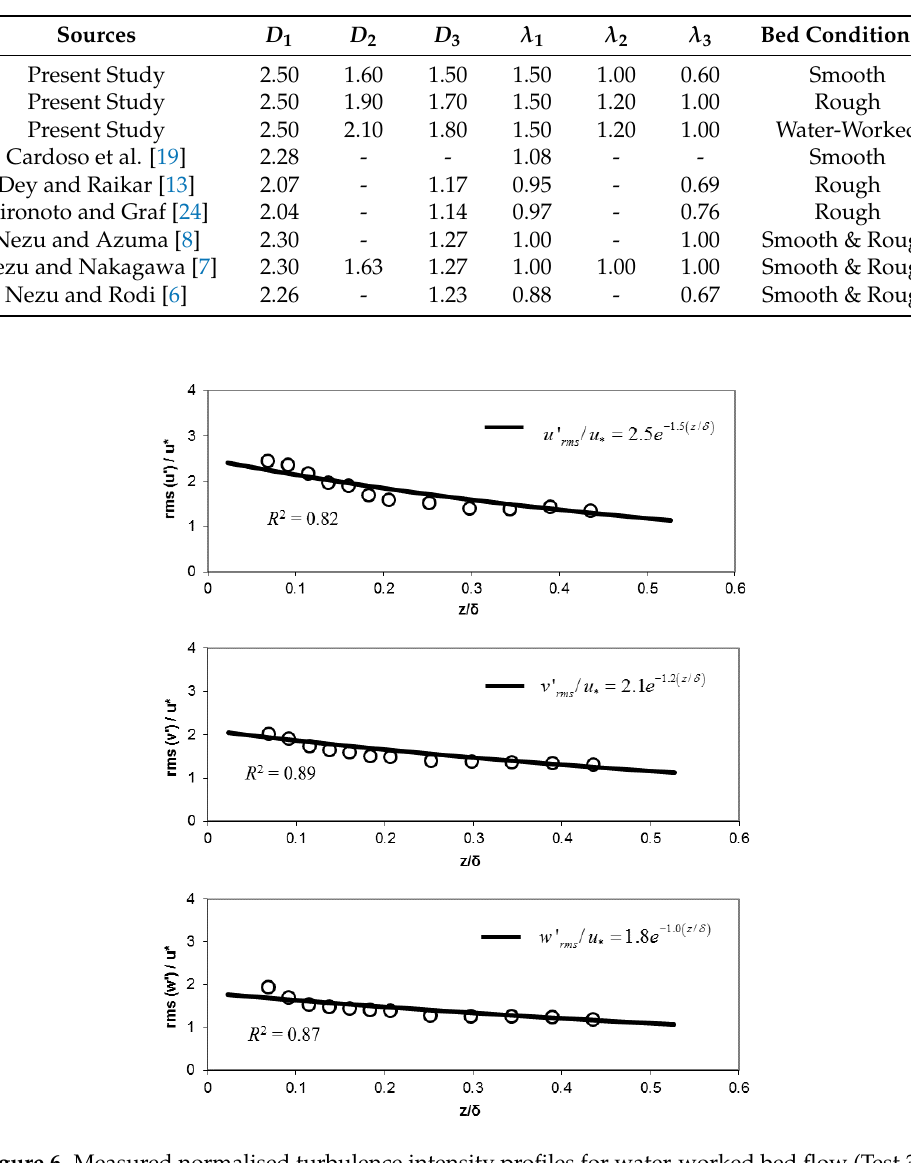
Figure 6. Measured normalised turbulence intensity profiles for water-worked bed flow (Test 3).